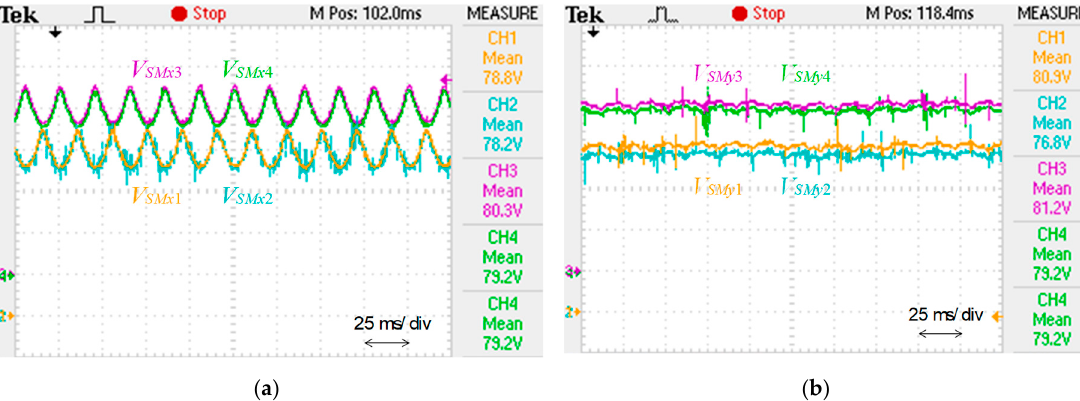
Figure 24. Experimental results (when two load sections are loaded): ( a ) SM voltages of section x converter; ( b ) SM voltages of section y converter. SM DC voltage ( V SM : 20 V/div).